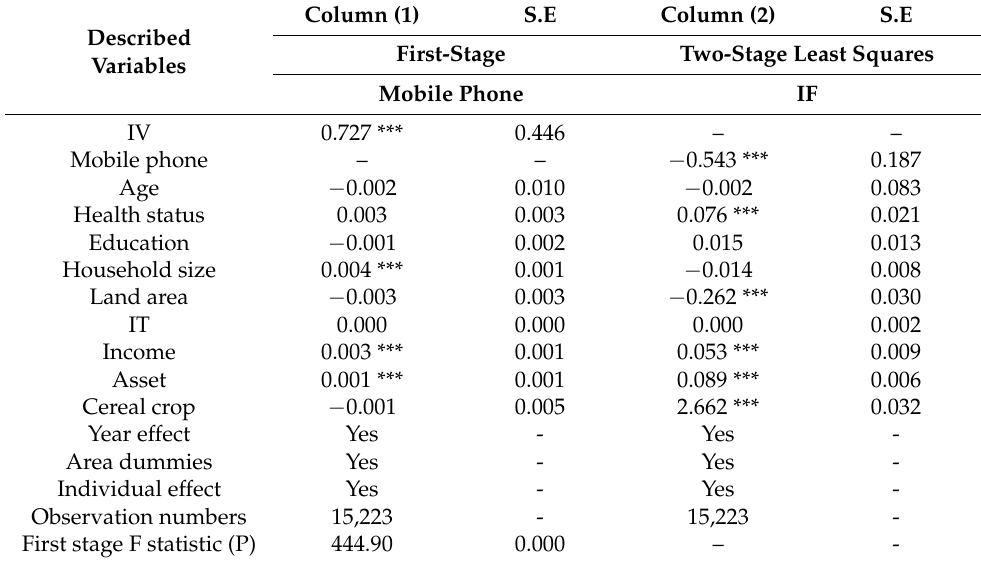
Table 7. Outcomes of two-stage